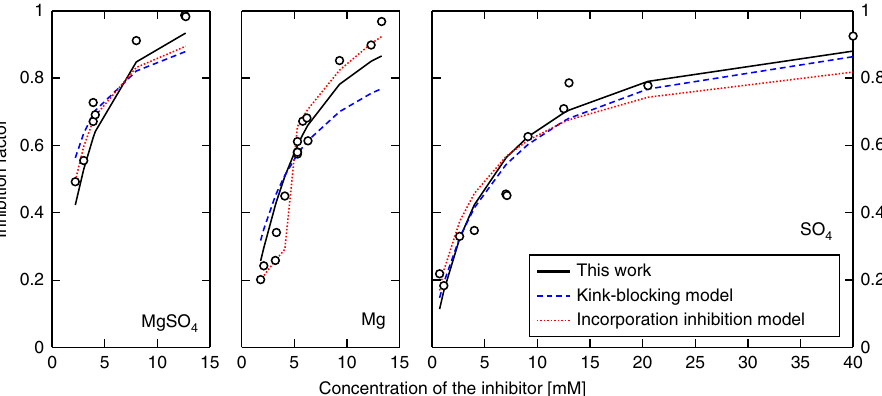
Fig. 2 Comparison between the model and the experimental growth inhibition data for Mg 2 + and SO 4 2 − . Fits for the growth inhibition data with the extended microkinetic model (this work, black), the kink-blocking model (blue) and the incorporation inhibition model (red) for MgSO 4 0 , Mg 2 + and SO 4 2 − . The microkinetic model fi ts best and requires only two physically meaningful parameters, adsorption energy for Mg 2 + and SO 4 2 −